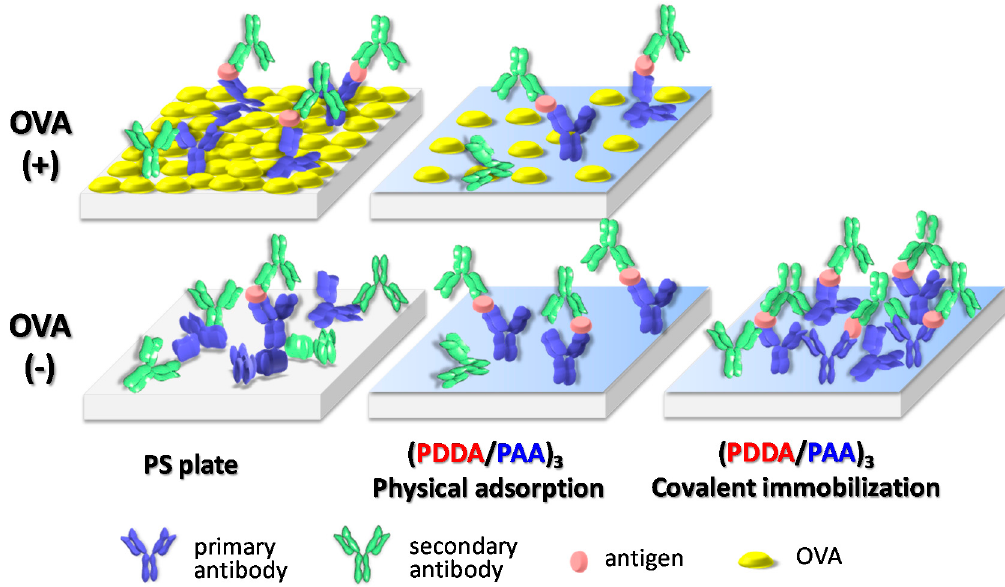
Figure 8. Proposed mechanism responsible for the signal and noise associated with secondary antibodies, on the PS plate and (PDDA/PAA) 3 , with, and without, OVA adsorption. The primary antibody could be immobilized on the (PDDA/PAA) 3 via physical adsorption and covalent immobilization.